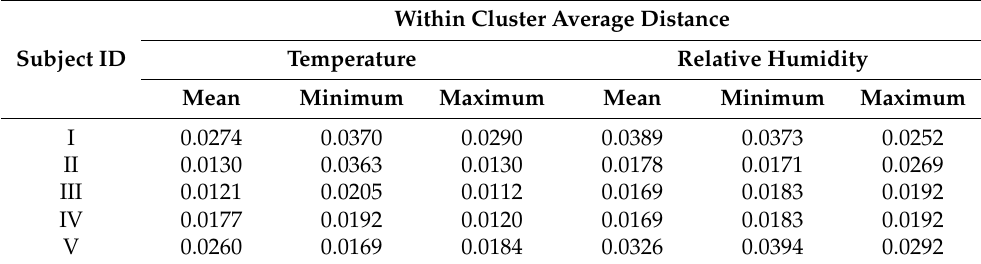
Table 3. Within cluster average distance by metric for each